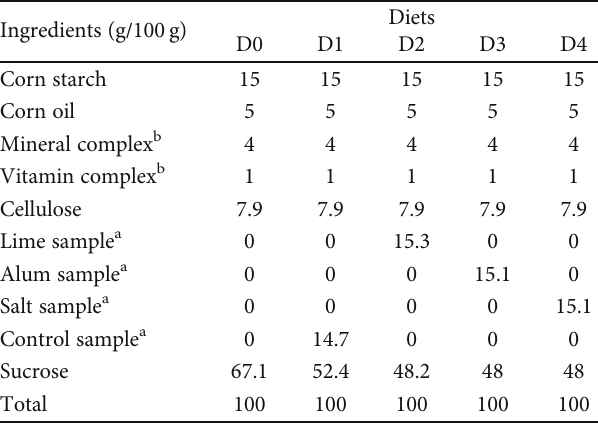
Table 1: Composition of the experimental diets used in the biological assay (g/100 g complete